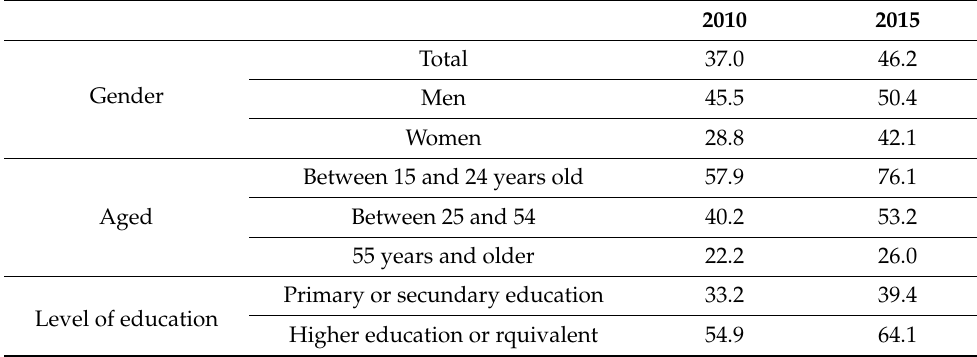
Table 3. Evolution of weekly sports practice (percentage corresponding to the total population studied in each